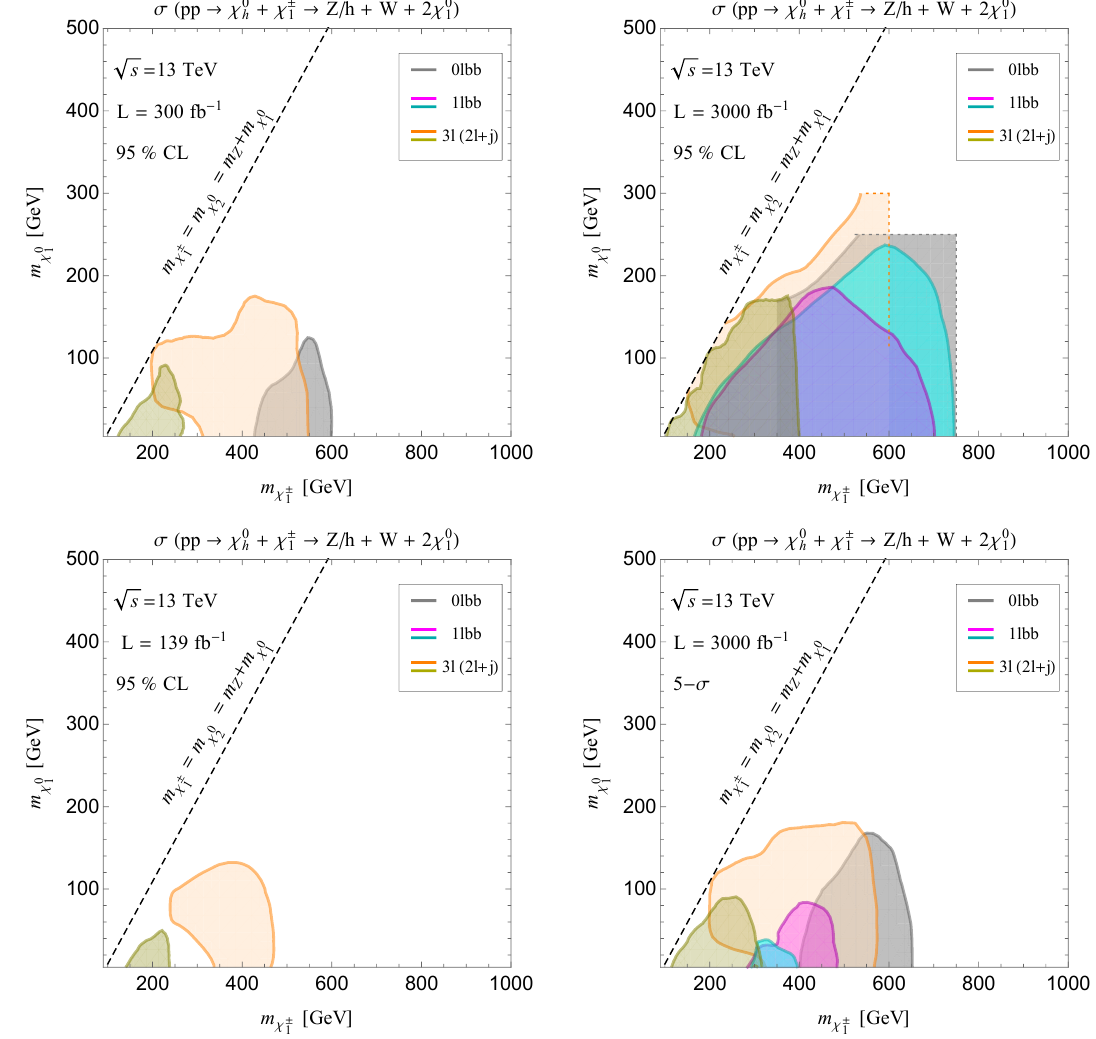
Figure 5 . Constraints on the Bino-Higgsino scenario projected to 300 and 3000 fb (cid:0) 1 at 95% con(cid:12)dence level in the top panel, 139 fb (cid:0) 1 at 95% con(cid:12)dence level and 3000 fb (cid:0) 1 at 5 (cid:27) in the lower panel. We choose tan (cid:12) = 5, but the results depend very weakly on this choice for the range of parameters that we explore. The 0 ‘bb (gray) [9] and 1 ‘bb (magenta, cyan) [10] come from the (cid:22) bb and W decay to hadronic or leptonic (cid:12)nal states. The (cid:31) 0 (cid:31) (cid:6) hW + 2 (cid:31) 0 channel, with h 2 ; 3 1 1 ! ! 3 ‘ (dark yellow) [12] and 3 ‘= 2 ‘ + j (orange) [8] come from the (cid:31) 0 (cid:31) (cid:6) ZW + 2 (cid:31) 0 channel, with 2 ; 3 1 1 ! Z 2 ‘ . For the gray and orange shaded region, there are dotted lines cutting o(cid:11) the high mass ! region because (cid:27) limit is not provided from HEP-Data.